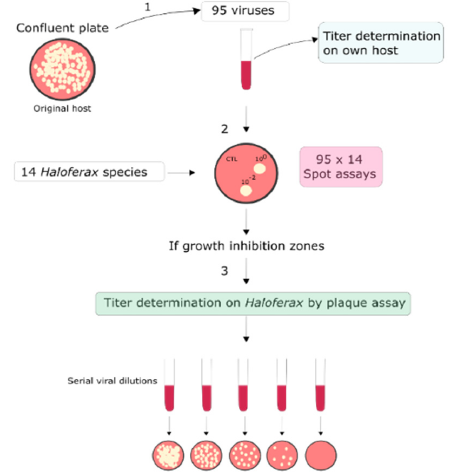
Figure 1. A schematic overview of the virus–host screen. Step 1 : Fresh virus stocks made from confluent or semi-confluent plates were prepared on their own host strains and the titers were determined on their own host strains. Step 2: 95 virus stocks (undiluted and 10 − 2 dilution) were spotted on lawns of 14 Haloferax strains. MGM medium was used as a negative control (CTL). Step 3: After incubation at 37 ◦ C, all virus- Haloferax pairs that resulted in growth inhibition on the spot-on lawn-assay were further tested by plaque assay by making serial dilutions of the virus stock and plating with the Haloferax strains to be tested. Viral plaques observed on Haloferax were counted, the titers were determined, and positive virus- Haloferax pairs were noted in Table